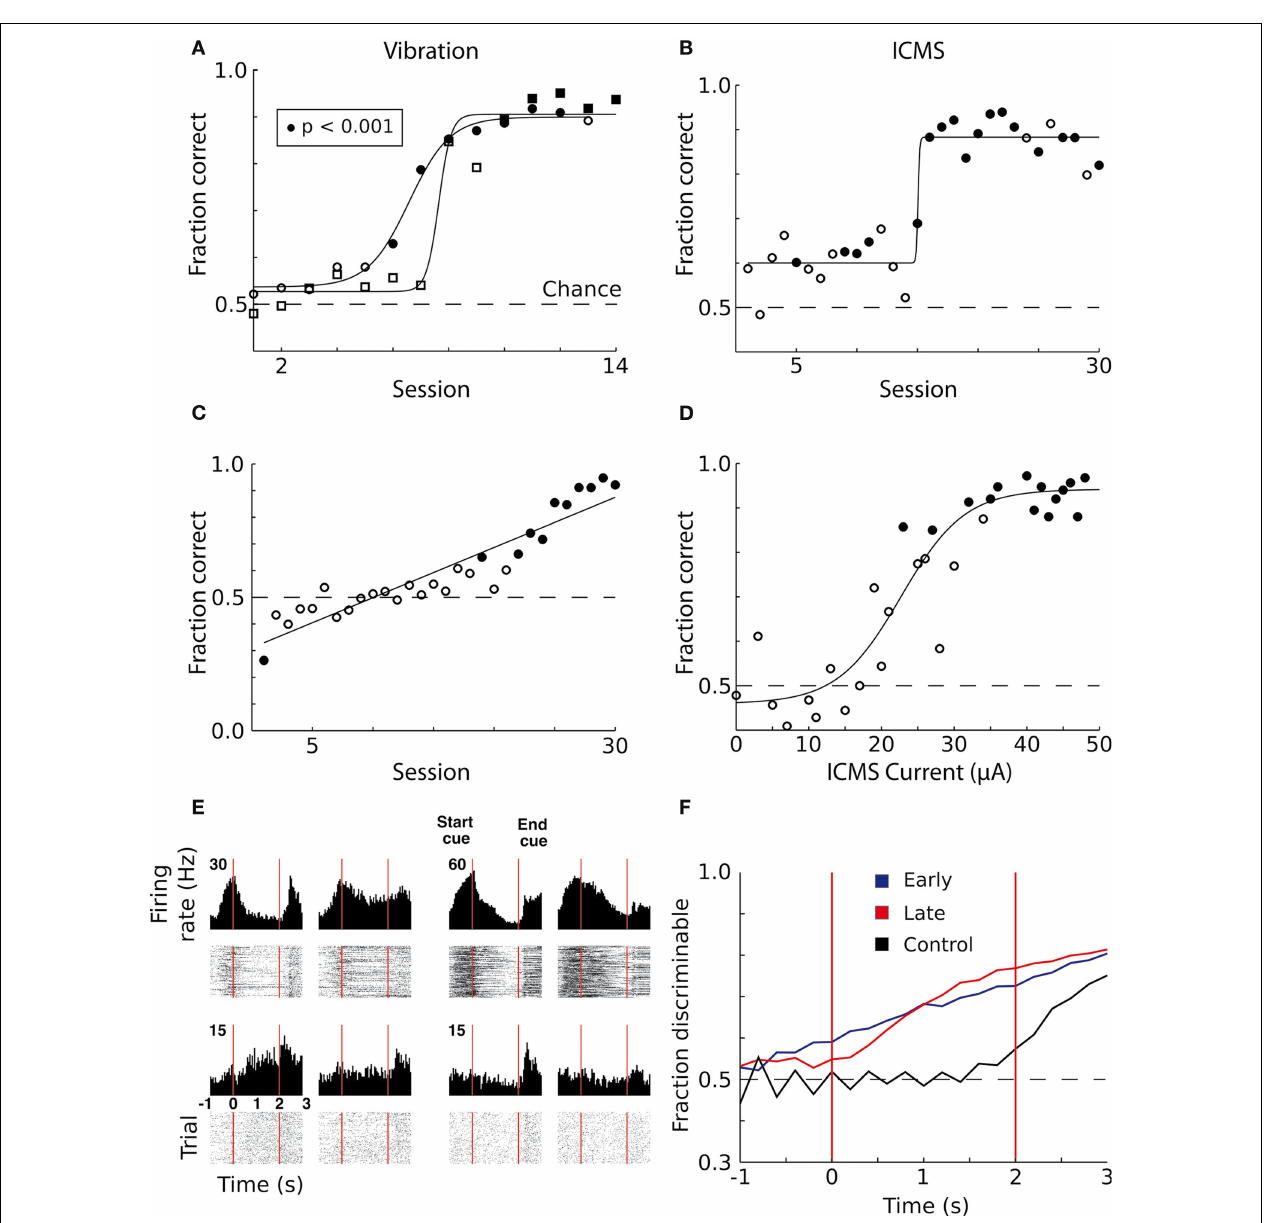
behavioral performance as ICMS pulse train amplitude was modulated. Solid line indicates sigmoidal fi t. (E) Peri-event time histograms and rasters of the activity of four single units from M1 of Monkey 1. Trials are aligned on cue onset. Vertical red lines indicate start and end of the cue interval. Left columns indicate ICMS trials during which the monkey moved to the left; right columns indicate movements to the right. (F) Average linear discriminant analysis predictions of movement direction as a function of time since cue onset show learning-related changes. Blue and red traces indicate averages across early ( n = 15) and late ( n = 15) sessions, respectively; control sessions ( n = 2) are shown in black. Vertical red lines indicate start and end of the cue